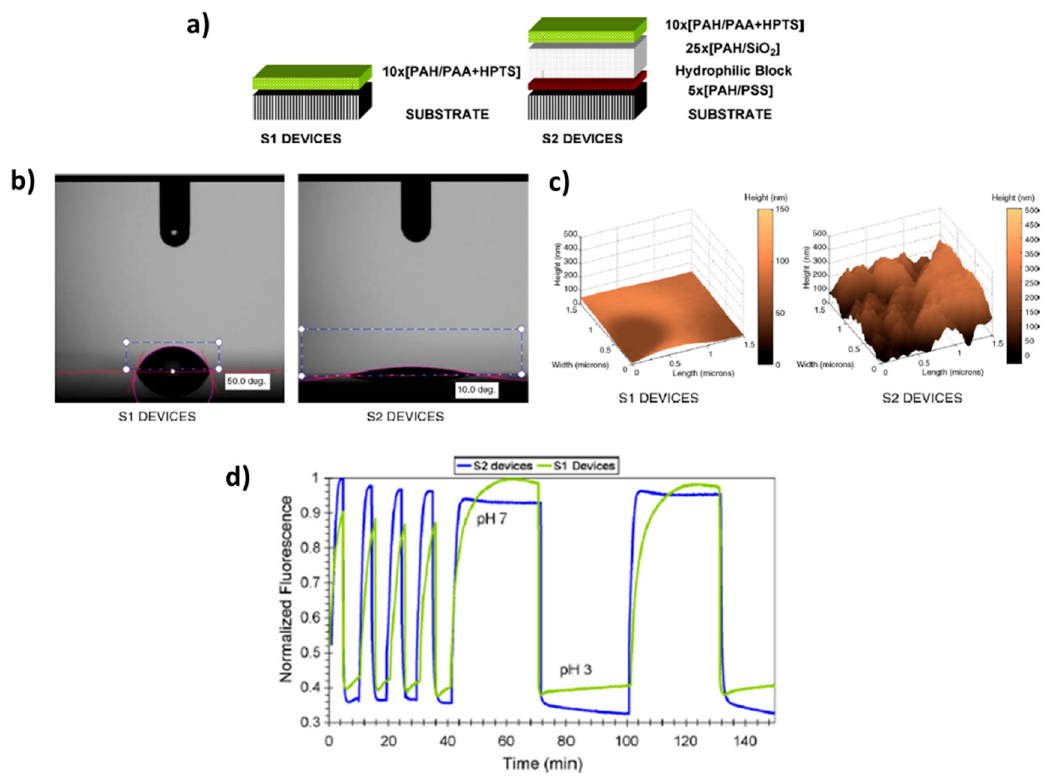
Figure 8. ( a ) Schematic representation of both structures (S1 and S2, respectively) for pH sensing; ( b ) Water contact angle (WCA) measurements and Atomic Force Microscopy (AFM) images ( c ) for S1 and S2, respectively; ( d ) normalized fluorescence emission responses of S1 and S2 when they are immersed in pH 3 and 7 buffers for 10 and 30 min of immersion time, respectively. Reprinted with permission of [53].